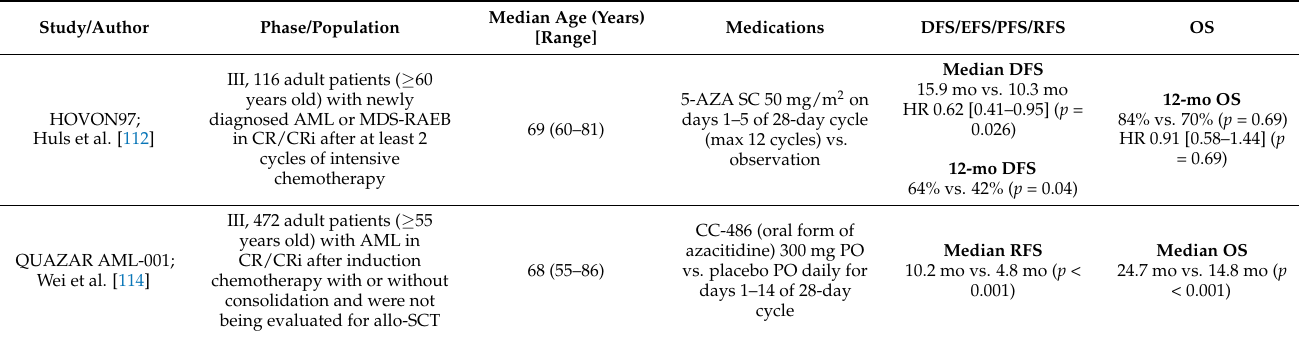
Table 5. AML maintenance regimens with an emphasis on older adult